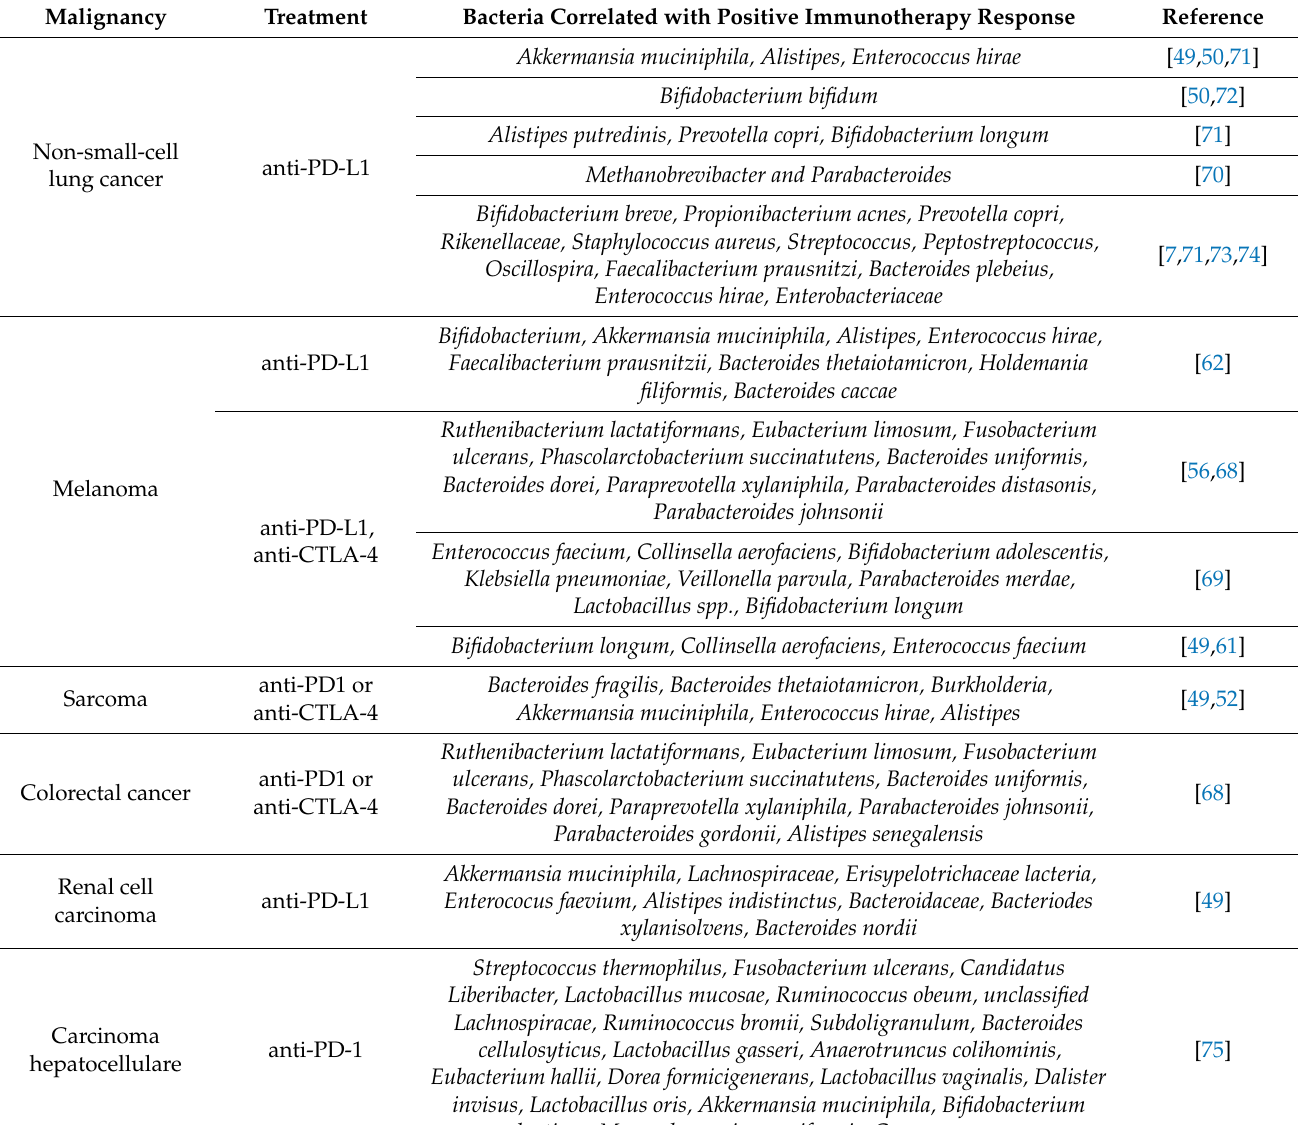
[Table 1]. In contrast, in patients with a good response to anti-PD-1 therapy, Ruminococcus bromii, Dialister and Sutterella occurred less [7,71,73]. Moreover, abundance of Ruminococcus unclassified was detected in the gut microbiome of patients with a poor response [71]. Table 1. Gut microbiota species associated with efficacy of cancer